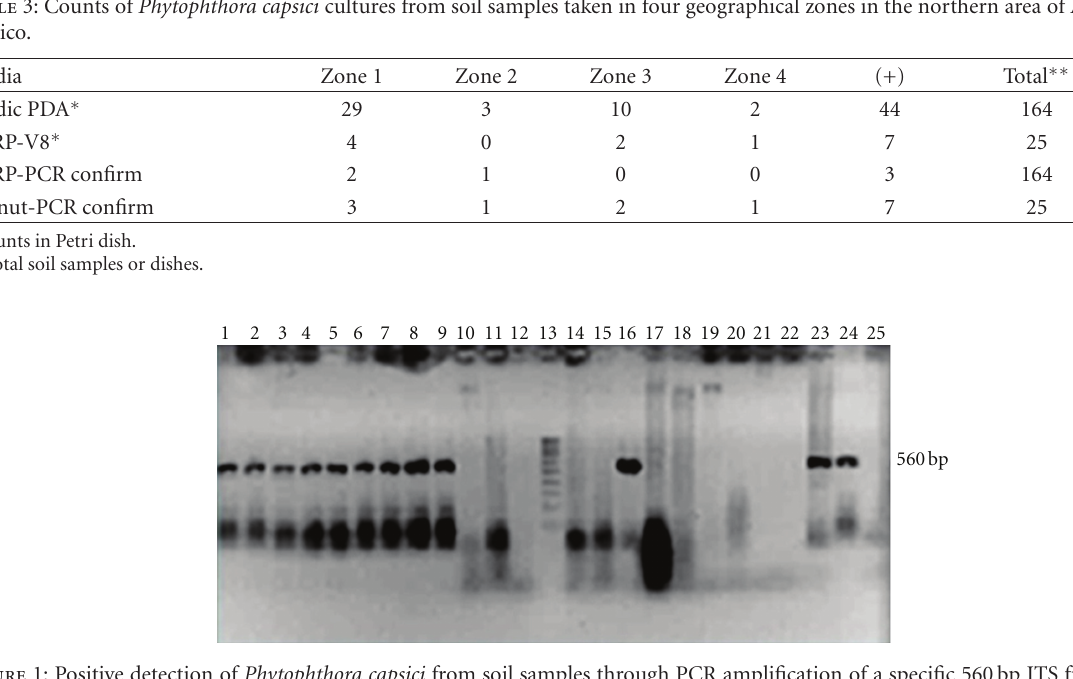
Figure 1: Positive detection of Phytophthora capsici from soil samples through PCR amplification of a specific 560 bp ITS fragment (lanes 1–7). Lane 13: molecular weight marker, lanes 24 and 25: positive and negative control, respectively. Lanes 8, 9, 16, and 23 are duplicates from the same